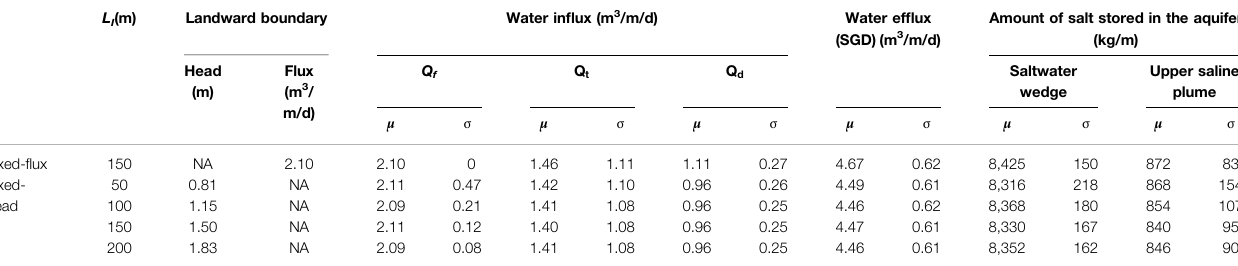
a L I istheinlandaquiferextent;Q f istheinlandfreshwaterinput;Q t isthetide-inducedseawatercirculation;Q d isthedensity-drivenseawatercirculation;SGDisthesubmarinegroundwater discharge; μ and σ aretheaveragedresultandthestandarddeviationoverthelasttwoyears(years2015 – 2016),respectively;NAmeansnotapplicable.Notethatthevaluesof fl uxandsalt mass are calculated per unit width of the